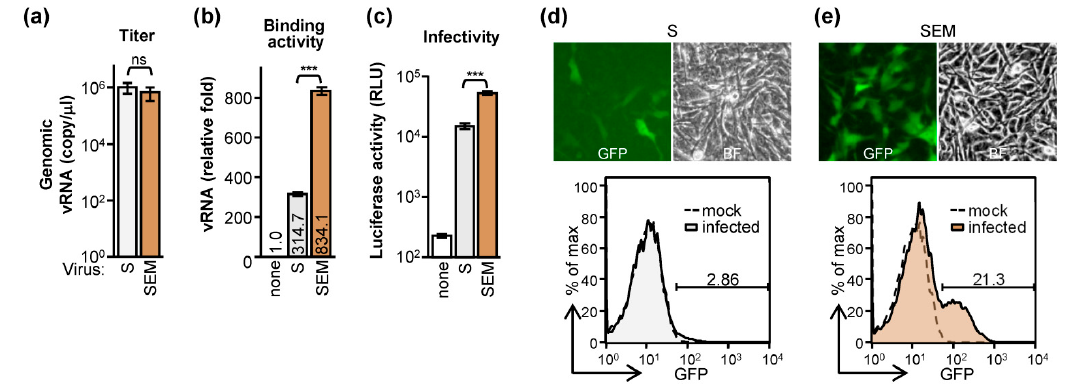
Figure 4. SARS-CoV-2 E and M proteins elevate the pseudovirion infectivity: ( a ) the S-alone and SEM pseudovirus titer were measured by qRT-PCR targeting genomic RNA of the virion. ( b ) BHK-hACE2 cells were incubated with S-alone or SEM pseudovirus at 4 °C for 3 h and then washed. The virus-binding activity was estimated by analyzing genomic RNA of the virion bound to the cell surface. ( c ) BHK-hACE2 cells were infected with S-alone or SEM-pseudovirus harboring FLuc reporter. The luciferase activity was measured at 48 h post-infection. Data ( a – c ) are mean ± SD, n = 3 per group, and were compared by two-tailed Student’s t test. ns, no significance; ***, p < 0.001. ( d , e ) BHK-hACE2 cells were infected with the S-alone ( d ) or SEM ( e ) pseudovirus harboring GFP reporter as indicated. The infected cells were revealed by fluorescence microscopy (upper panel) and flow cytometry (lower panel).